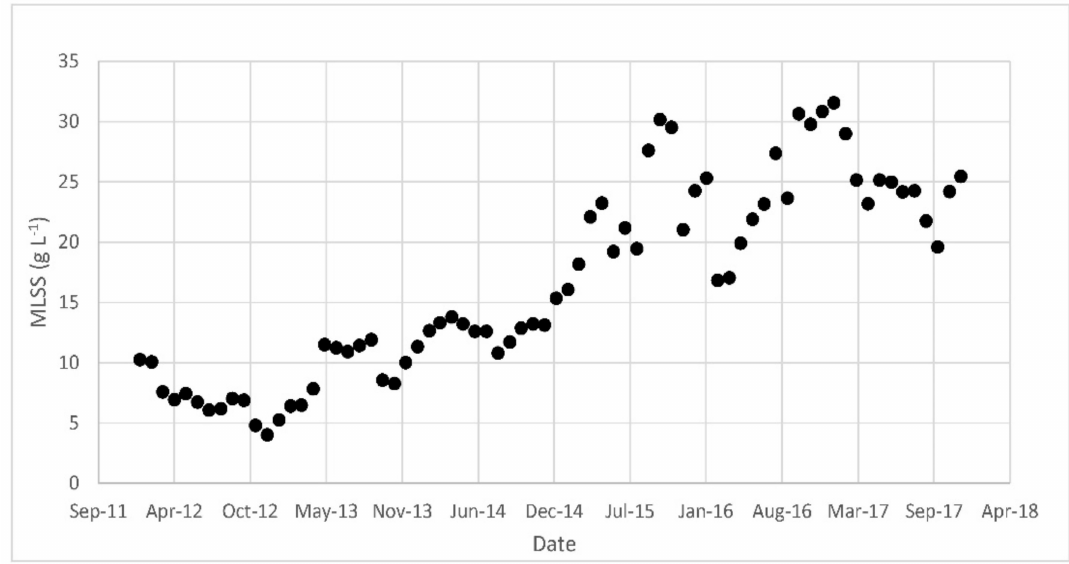
Figure 2. Mixed liquor suspended solids MLSS over time inside the oxidation/nitrification